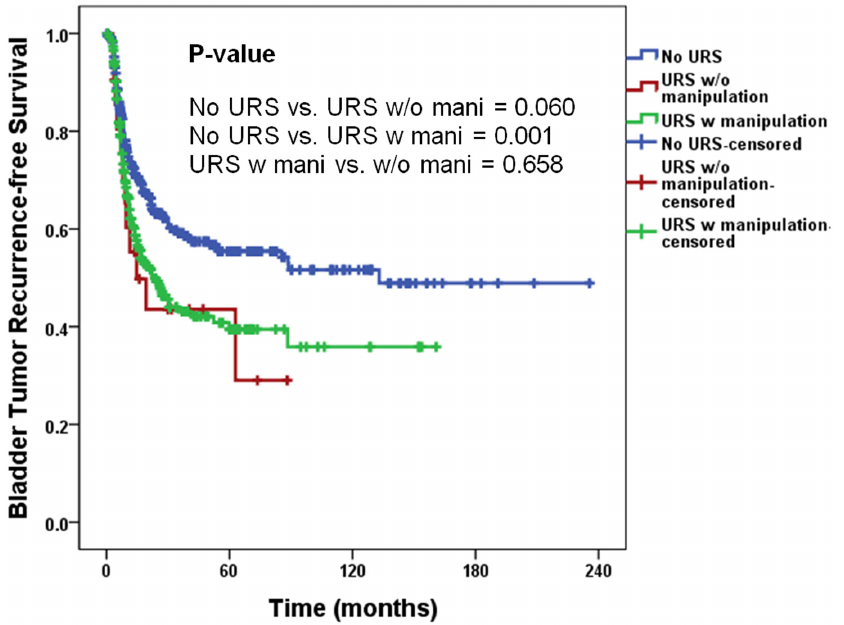
Fig 3. Survival analysis of intravesical recurrence according to manipulation. mani, manipulation; URS, ureterorenoscopy; w, with; w/o, without. n = 72) and delayed RNU after URS (operations at separate day, n = 210). The IVR rate of the delayed RNU group did not differ from that of the concurrent RNU group ( P = 0.545, Fig 4).